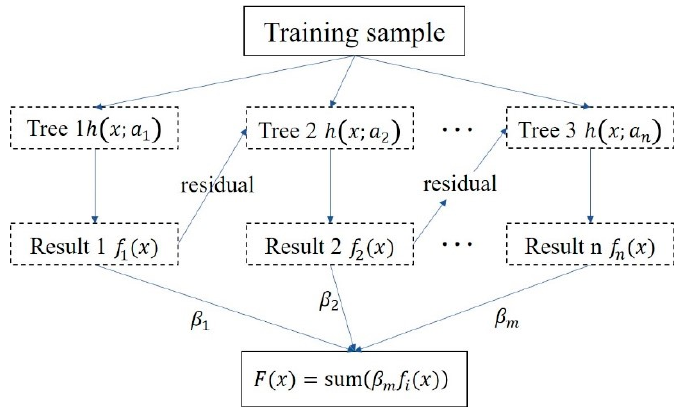
Figure 2. Diagram of GBRT algorithm.